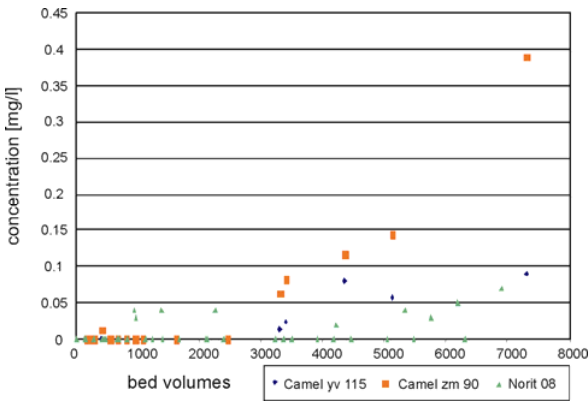
Fig. 3a . Comparison of chlorites concentration in GAC filter effluents